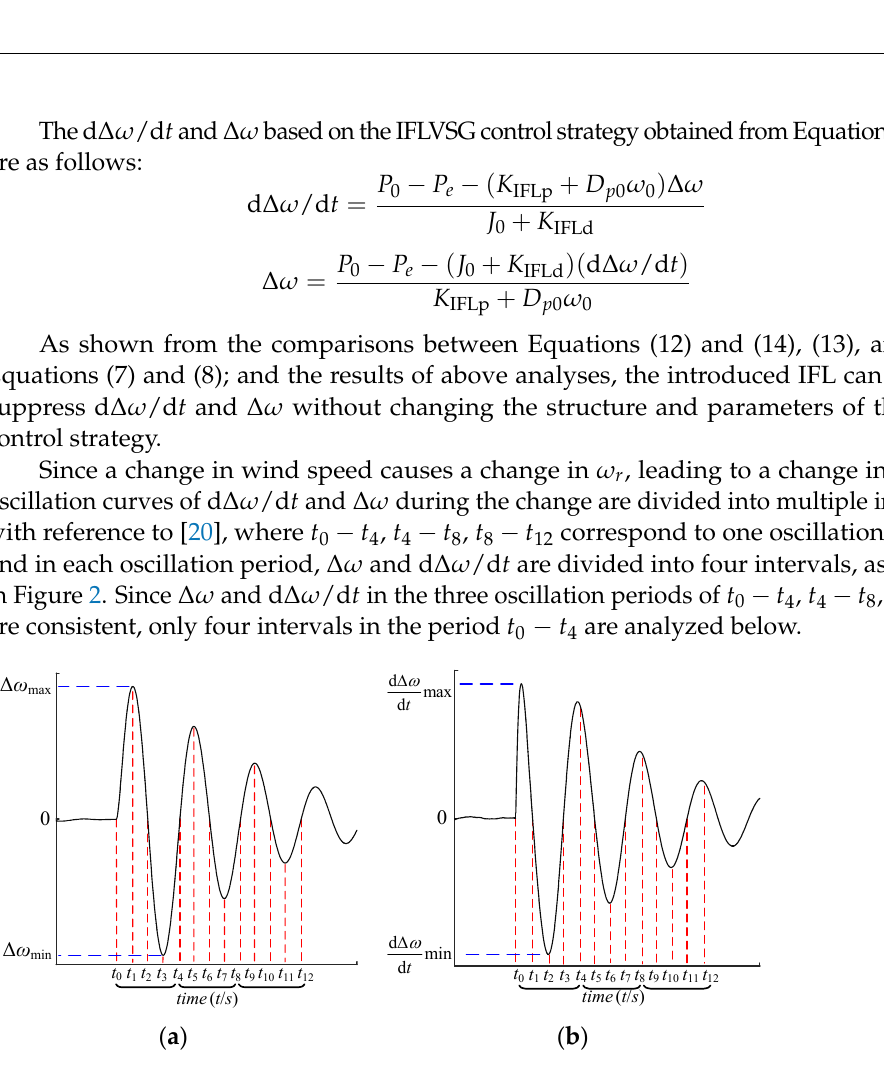
Figure 2. Oscillation curves of Δ ω and d Δ ω /d t during change processes: ( a ) Oscillation curve of Δ ω ; ( b ) Oscillation curve of d Δ ω /d t .